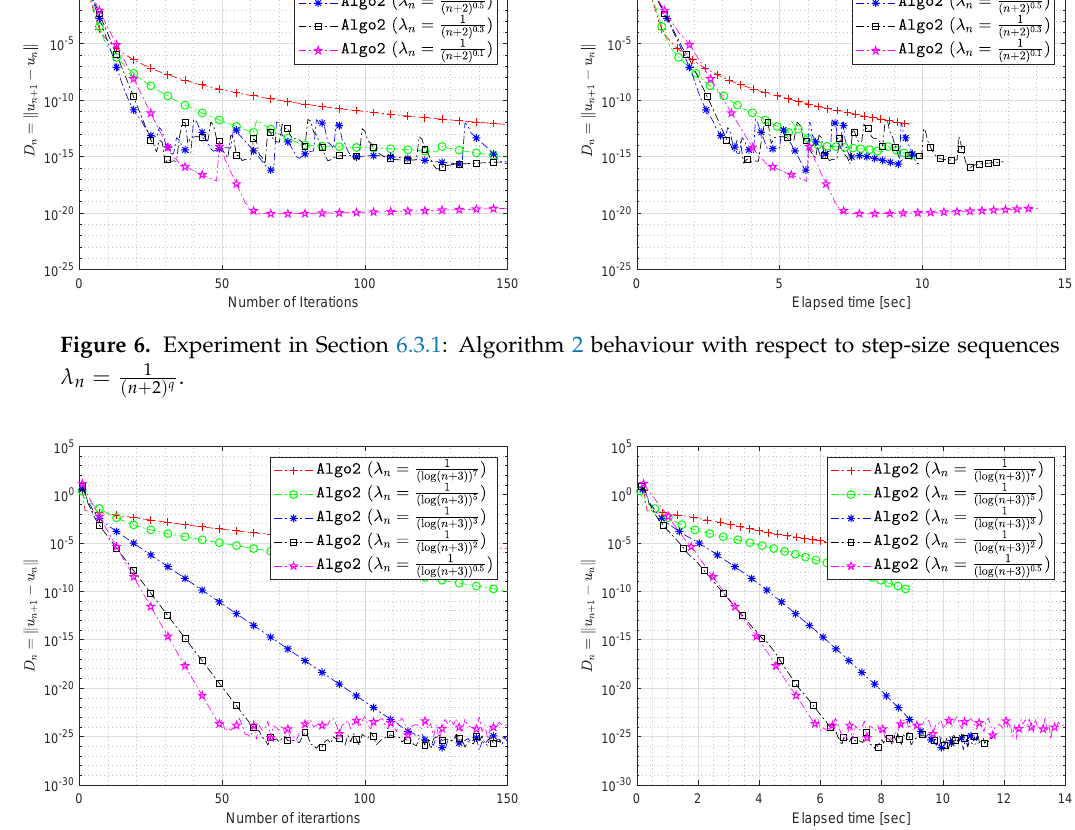
Figure 7. Experiment in Section 6.3.1: Algorithm 2 behaviour with respect to step-size sequences λ n = 1 ( log ( n + 3 )) q